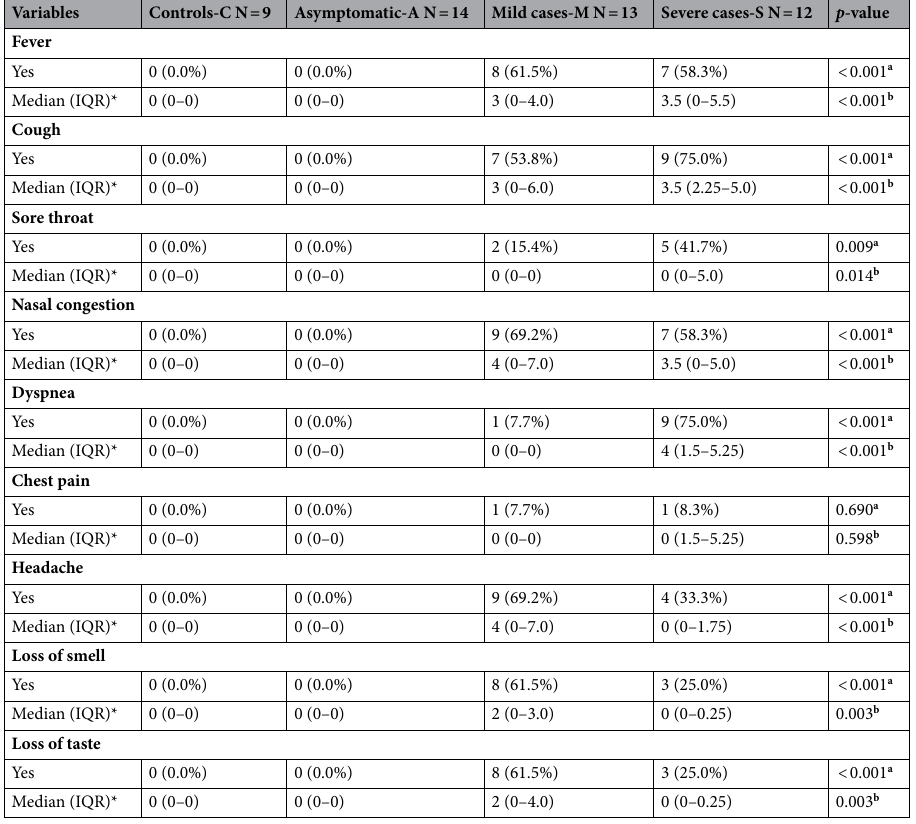
Table 2. Signs and symptoms according to clinical outcome in individuals with SARS-CoV-2 infection and negative controls (n = 48). Mild Cases-M Non-hospitalized; Severe Cases-S Hospitalized. a Fisher’s exact test.